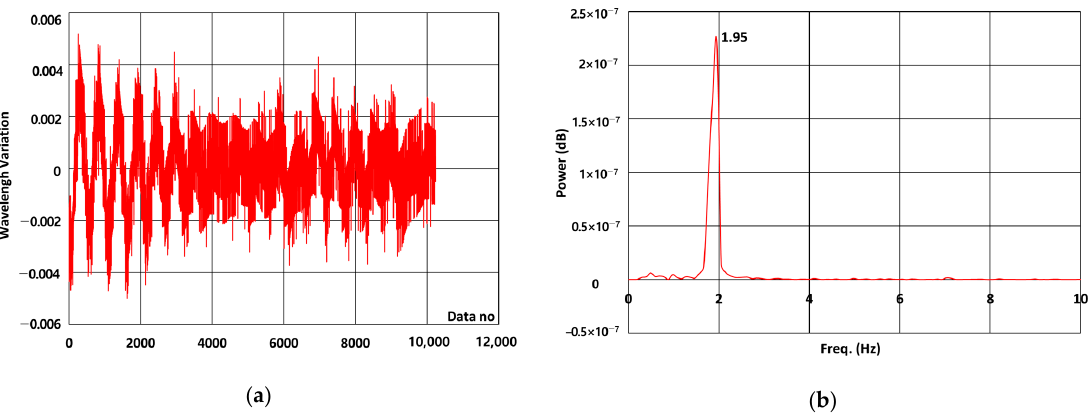
Figure 15. Data acquired on the road bridge in the previous test: ( a ) Dynamic data (wavelength variation) measured by OSPC strand; ( b ) Identification of natural frequency.